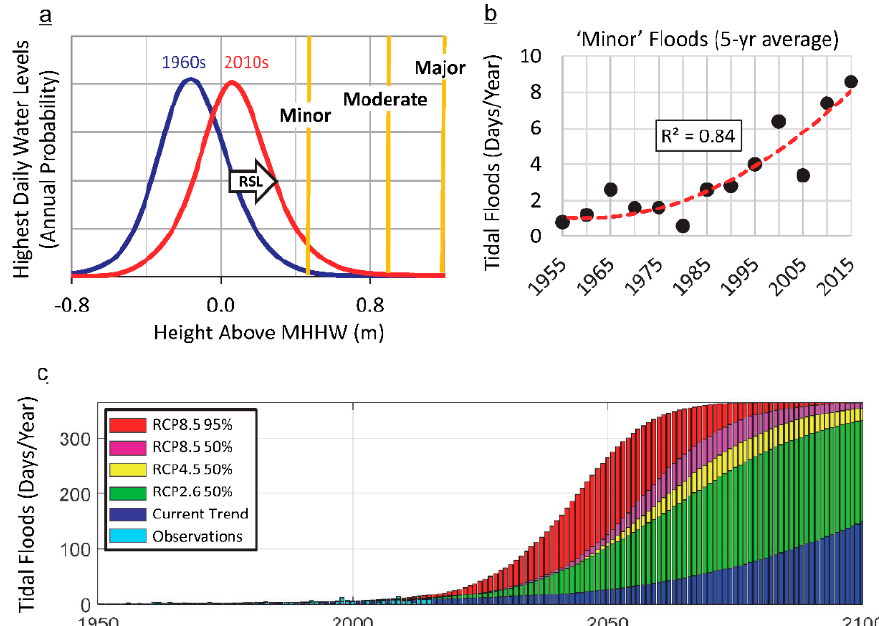
Figure 1. ( a ) Multi-year empirical (smoothed) distributions for daily highest water levels in Norfolk, VA, USA, for the 1960s and 2010s, showing extent that local relative sea level (RSL) rise has increased the flood probability relative to impact thresholds defined locally by NOAA’s National Weather Service [50] for minor (~0.5 m: nuisance level), moderate (~0.9 m) and major (~1.2 m: local level of Hurricane Sandy in 2012) impacts, relative to mean higher high water (MHHW) tidal datum of the National Tidal Datum Epoch (1983–2001) and due to RSL rise; ( b ) annual flood frequencies (based upon 5-year averages) in Norfolk for recurrent tidal floods with minor impacts are accelerating, as shown by the quadratic trend fit (goodness of fit [ R 2 ] = 0.84). From Sweet et al. [12]; In ( c ) are projections of local minor daily floods for Norfolk, VA of Sweet and Park [43] forced by the local SLR trend (navy blue) and those of Kopp et al. [8] based upon representation concentration pathways (RCP). The y -axis in c saturates at 365 days/year with a flood.